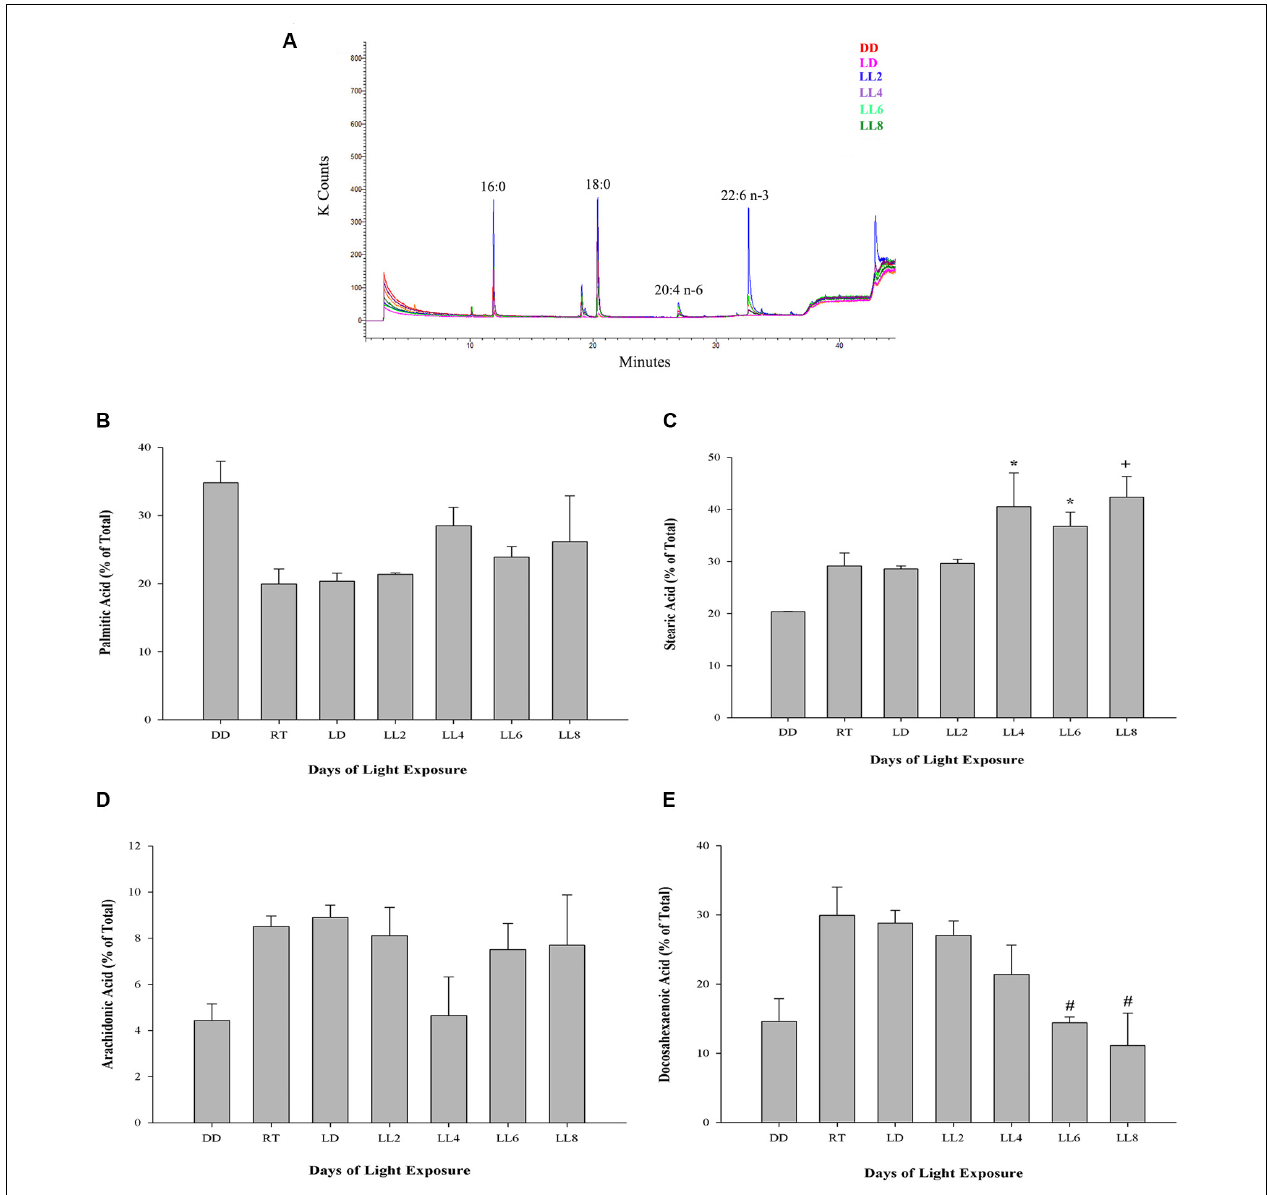
FIGURE 4 | Fatty acid composition in light-treated rat retinas. (A) Full scan GC-MS total ion chromatograms of rat retina from controls (DD and LD) and rats exposed to 2, 4, 6 and 8 days of LL. 16:0, palmitic acid; 18:0, stearic acid; 20:4 n-6, arachidonic acid; 22:6 n-3, docosahexaenoic acid. (B–E) Quantification of palmitic (B) , stearic (C) , arachidonic (D) and docosahexaenoic acid (E) from controls (DD, RT and LD) and animals exposed for 2, 4, 6 and 8 days of constant light (LL), expressed as a percentage of total fatty acids, respectively. Data are mean ± SE, n = 1 animal/group from three independent experiments, ∗ p < 0.05 vs.